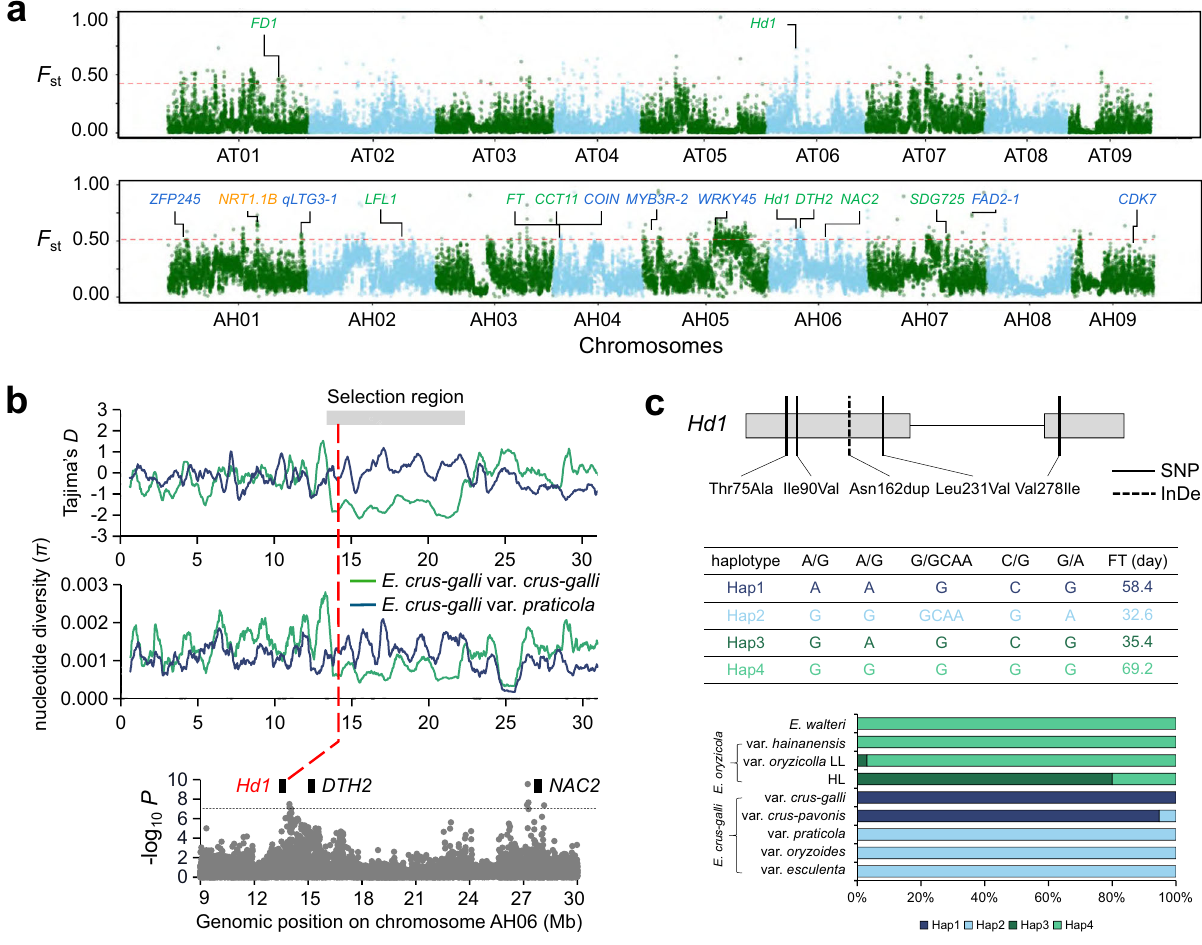
Fig. 4 Local adaptation of Echinochloa accessions. a Genomic differentiation ( F st ) between high-latitude (HL) and low-latitude (LL) E. oryzicola var. oryzicola populations (upper panel), and between E. crus-galli var. praticola and var. crus-galli (lower panel). Genes related to fl owering (green) and cold tolerance (blue) in the top 1% F st windows (red horizontal dashed lines) in E. oryzicola and E. crus-galli subgenomes A are shown, respectively. b Selection features (Tajima ’ s D and nucleotide diversity π ) of Hd1 and genome-wide association study on fl owering time in E. crus-galli . The red dashed line indicates the genomic position of Hd1 on chromosome AH06. c Analysis of Hd1 haplotypes in E. oryzicola and E. crus-galli . Four haplotypes composed by four SNPs and one InDel show differences in fl owering time. Source data are provided as a Source data fi